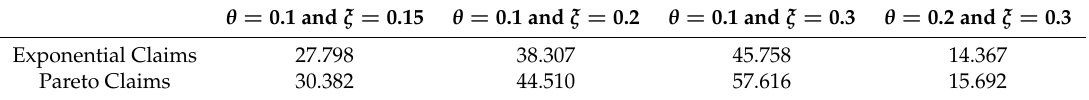
Table 5. The smallest initial surplus u S under the excess of loss reinsurance. θ = 0.1 and ξ = 0.15 θ = 0.1 and ξ = 0.2 θ = 0.1 and ξ =